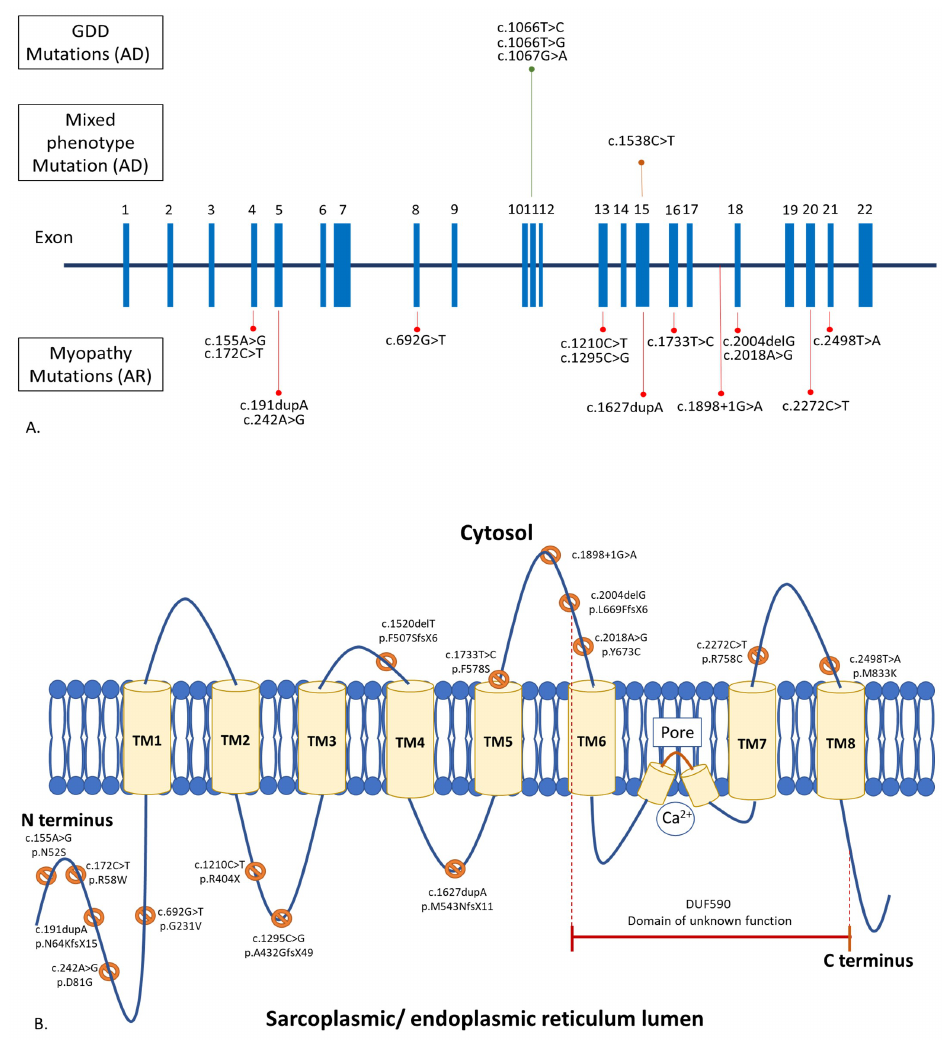
Figure 1. Schematic representation of anoctamin 5 gene ( ANO5 ) ( A ) and protein (ANO5) ( B ) display- ing the relatively common mutations underlying autosomal recessive (AR) muscle disorders (more than 5 reported cases), autosomal dominant (AD) gnathodiaphyseal dysplasia (GDD), and combined muscle and bone